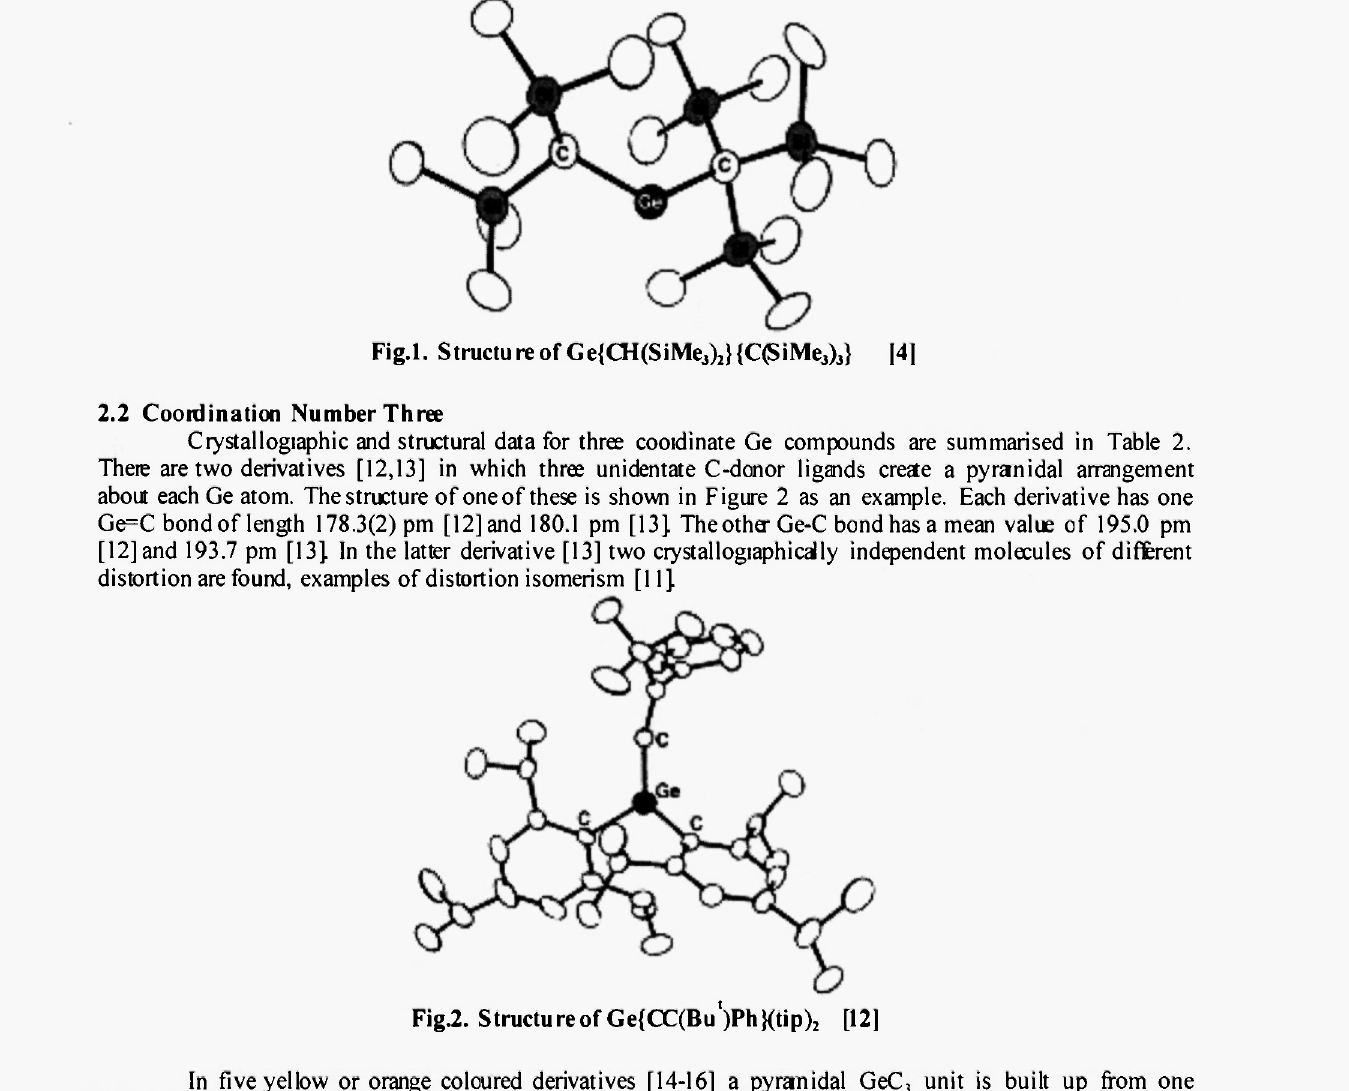
Fig.2. Structure of Ge{CC(Bu')PhKtip) 2